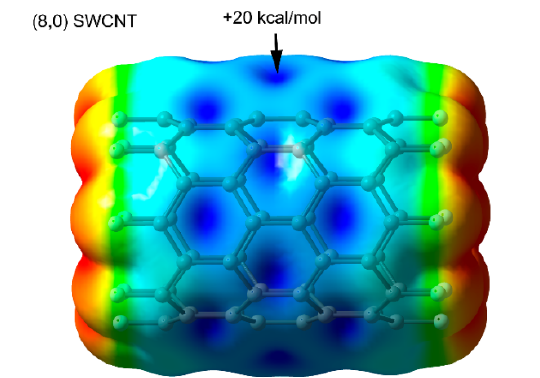
Figure 13. MEP surface of (8,0) SWCNT at the B3LYP/6-31+G* (isosurface 0.001 a.u.) saturated with fluorine at both ends.